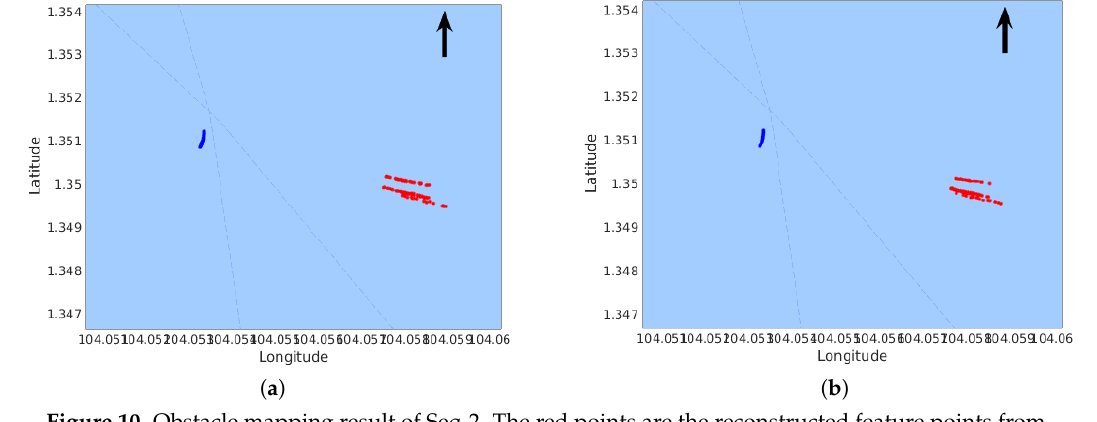
Figure 10. Obstacle mapping result of Seq-2. The red points are the reconstructed feature points from obstacles; The blue curve represents the trajectory of our USV; The arrow points to the direction of North. ( a ) Triangulation using one frame pair; ( b ) triangulation using ten frame